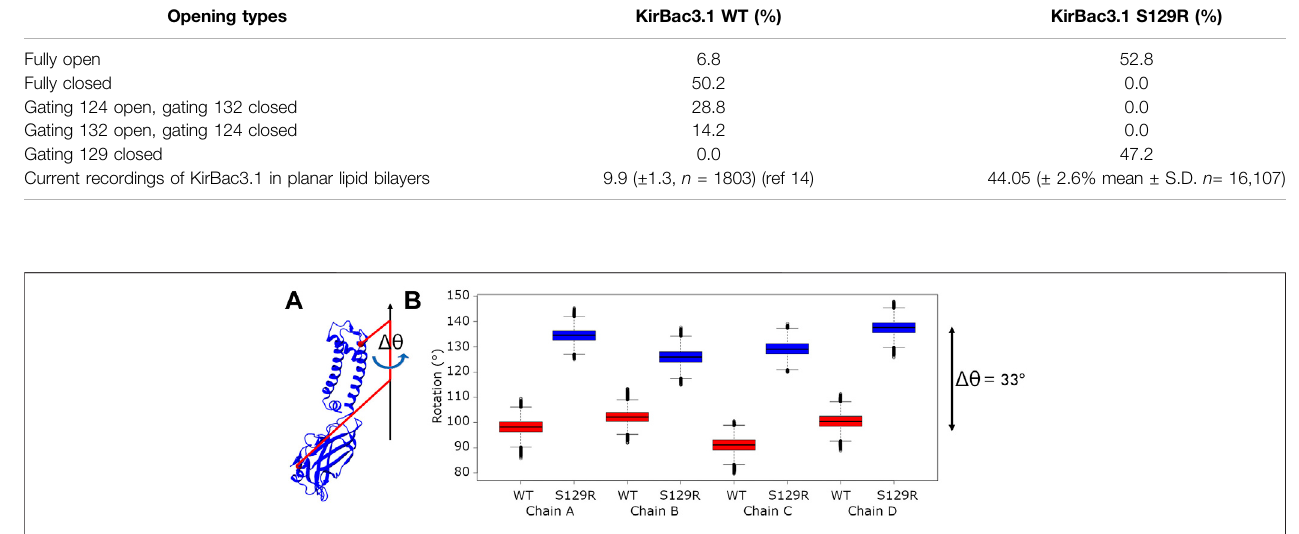
FIGURE5| Rotationofthecytoplasmicdomain (A) De fi nitionofthecytoplasmicdomainrotationangleofagivenchain; (B) Boxplotsoftherotationangle ’ svaluesof the cytoplasmic domain for each chain for KirBac3.1 WT and KirBac3.1 S129R. The angles were computed on all the relaxed structures of KirBac3.1 WT (red) and KirBac3.1 S129R (blue). The middle line of each box corresponds on the median values. The variation of the 33 ° between the WT and mutant were obtained from these average